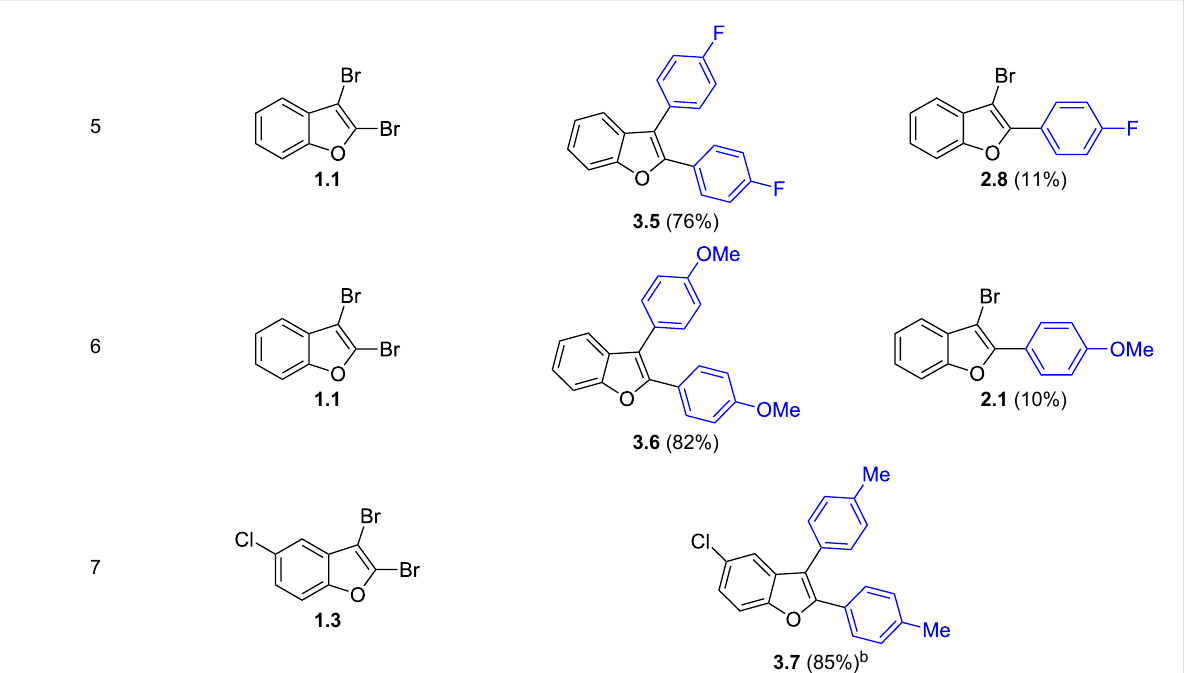
Table 4: Bis-coupling of 2,3-dibromobenzofurans. a (continued)